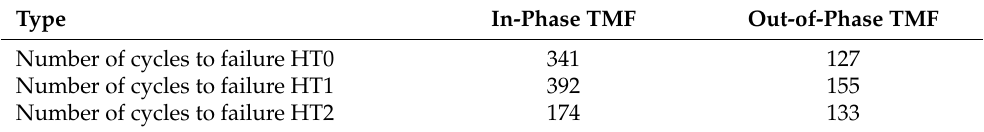
Table 4. Overview of the in-phase and out-of-phase TMF tests with the number of cycles to failure.